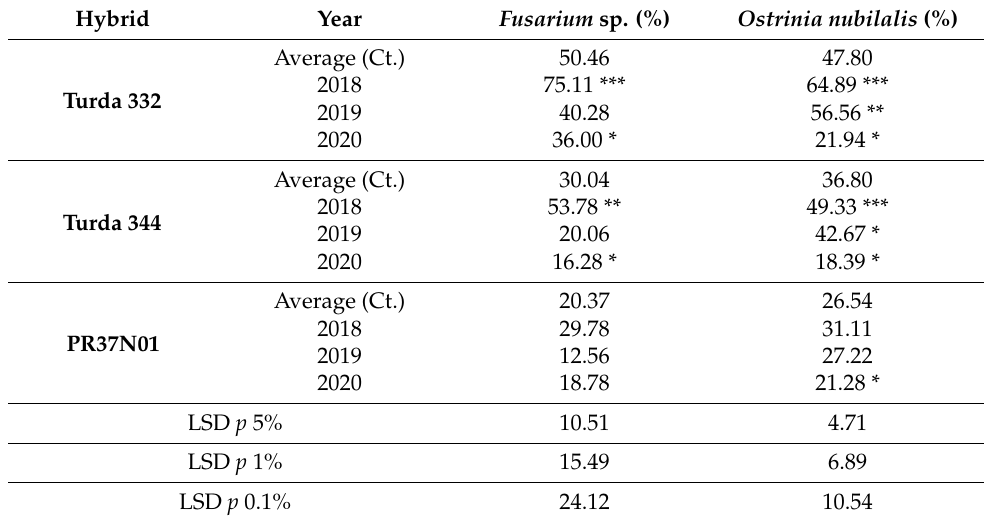
Table 4. Influence of the interaction hybrid × year on disease and pest incidence in maize.